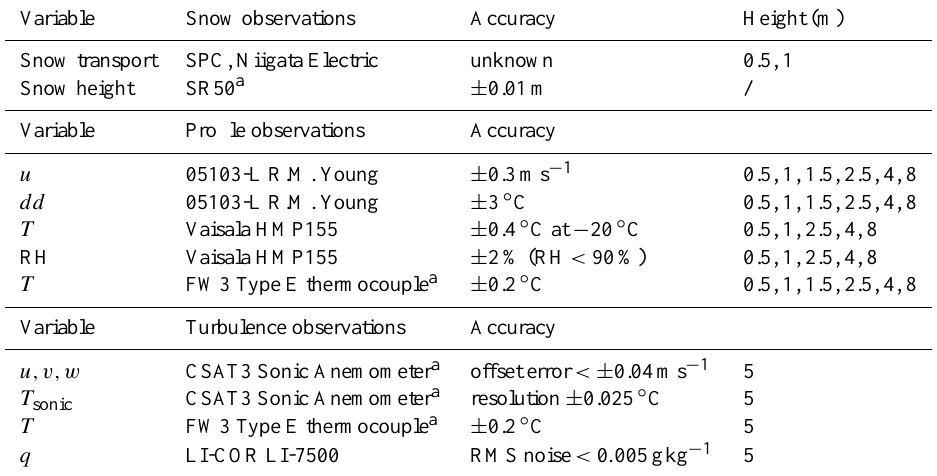
Table 1. A list of all meteorological and turbulence instruments (sensors marked with a are manufactured by Campbell Scientific, Inc.). Variable Snow observations Accuracy Height (m) Snow transport SPC, Niigata Electric unknown 0.5, 1 Snow height SR50 a ± 0.01m / Variable Profile observations Accuracy u 05103-L R.M. Young ± 0.3ms − 1 0.5, 1, 1.5, 2.5, 4, 8 dd 05103-L R.M. Young ± 3 ◦ C 0.5, 1, 1.5, 2.5, 4, 8 T Vaisala HMP155 ± 0.4 ◦ C at − 20 ◦ C 0.5, 1, 2.5, 4, 8 RH Vaisala HMP155 ± 2% (RH < 90%) 0.5, 1, 2.5, 4, 8 T FW3 Type E thermocouple a ± 0.2 ◦ C 0.5, 1, 1.5, 2.5, 4, 8 Variable Turbulence observations Accuracy u,v,w CSAT3 Sonic Anemometer a offset error < ± 0.04ms − 1 5 T sonic CSAT3 Sonic Anemometer a resolution ± 0.025 ◦ C 5 T FW3 Type E thermocouple a ± 0.2 ◦ C 5 q LI-COR LI-7500